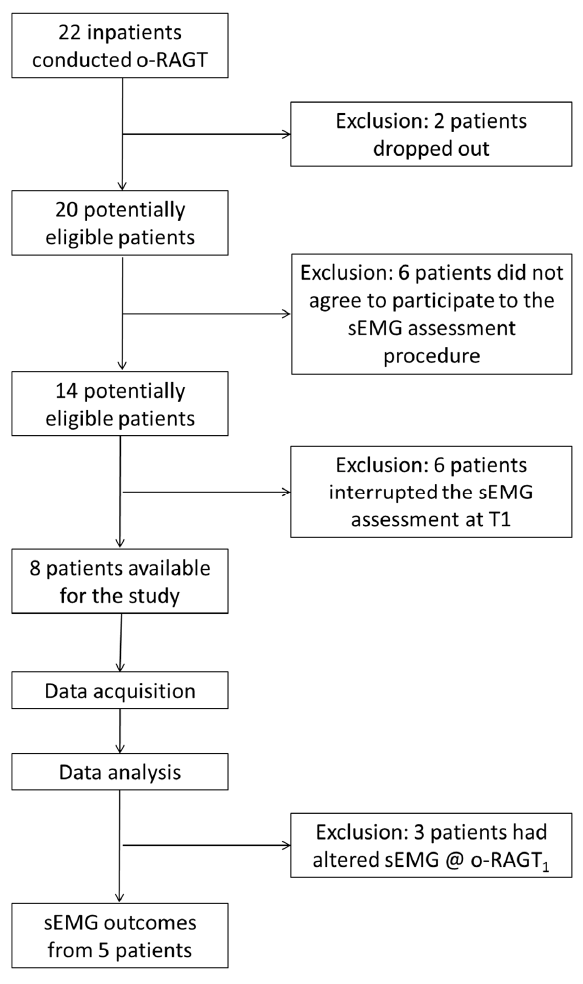
Figure 1. Flowchart of the study procedure. Table 1. Demographic and clinical characteristics of the sample. Table 2. Bilateral symmetry (BS) coefficient at T1 and T2 during 10MWT, and during the first session of overground Robot-Assisted Gait Training (o-RAGT) (o-RAGT 1